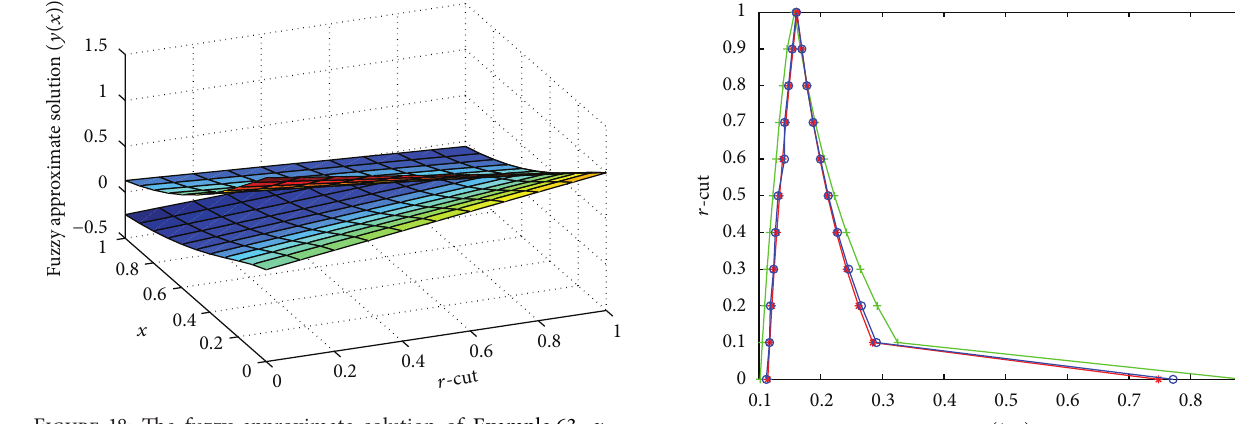
Figure 18: The fuzzy approximate solution of Example 63, 𝛼 = 0.95, 𝑚 = 8 .